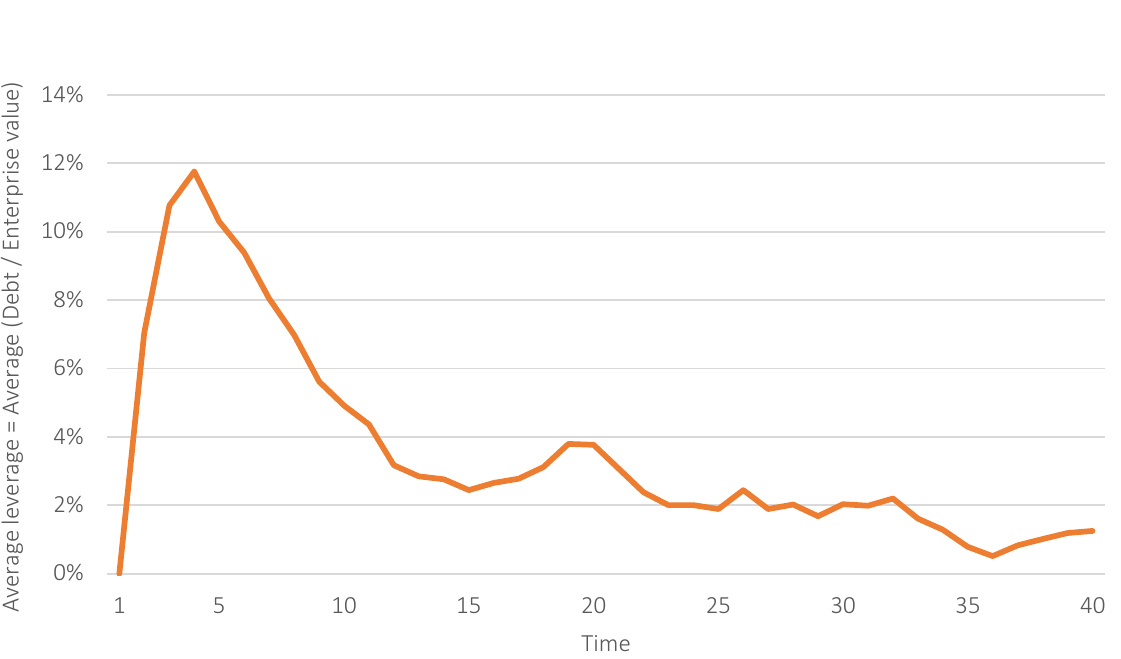
Figure 14. Evolution of Leverage ratio (Debt/Enterprise value) in Islamic LBO market